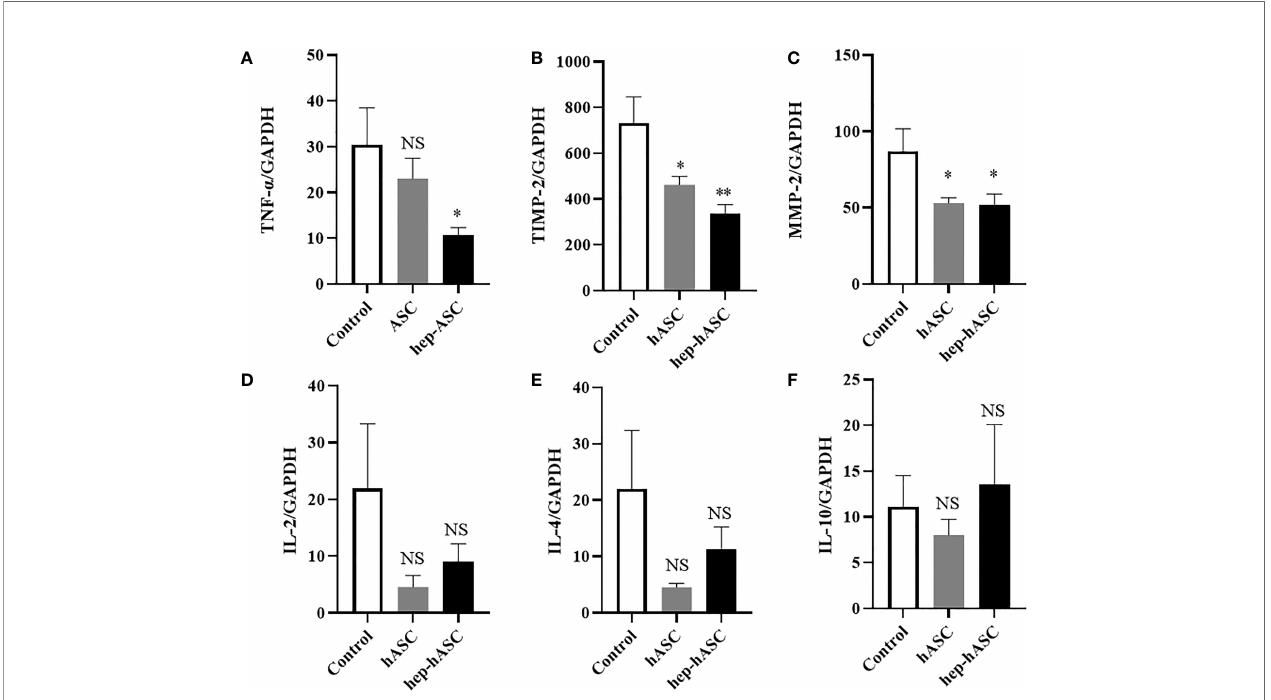
FIGURE 5 | Quantitative real-time RT-PCR analysis of kidney mRNA expression. Relative mRNA expression levels of TNF- a (A) , TIMP-2 (B) , MMP-2 (C) , IL-2 (D) , IL-4 (E) , IL-10 (F) in the kidneys in NZB/W F1 mice at 26 weeks. Data are shown as mean ± SEM (N=12 mice per group). *P < 0.05. **P < 0.01. NS, not signi fi cant vs. control